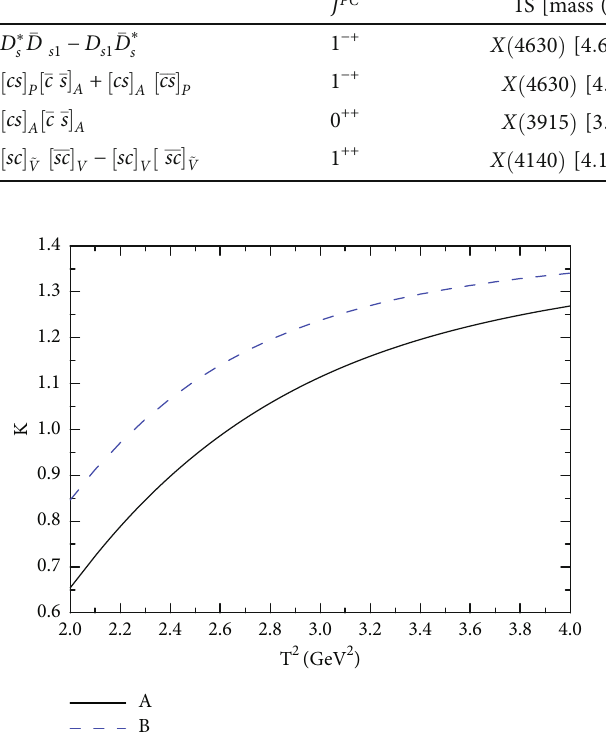
Figure 2: The values of the κ with variations of the Borel parameter T 2 , where the A and B come from the QCD sum rules in Eqs. (20) and (21), respectively.